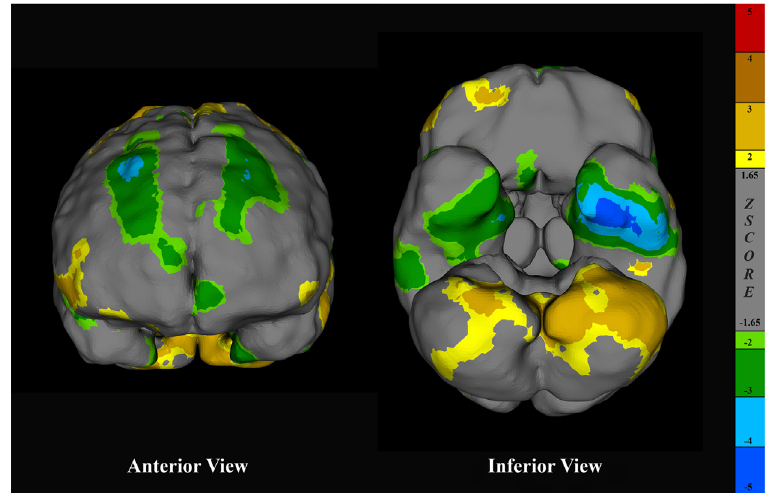
Figure 11. Surface projections of a brain SPECT scan rendered in CereMetrix ® demonstrating asymmetric frontal and temporal hypoperfusion in a person with suspected TBI